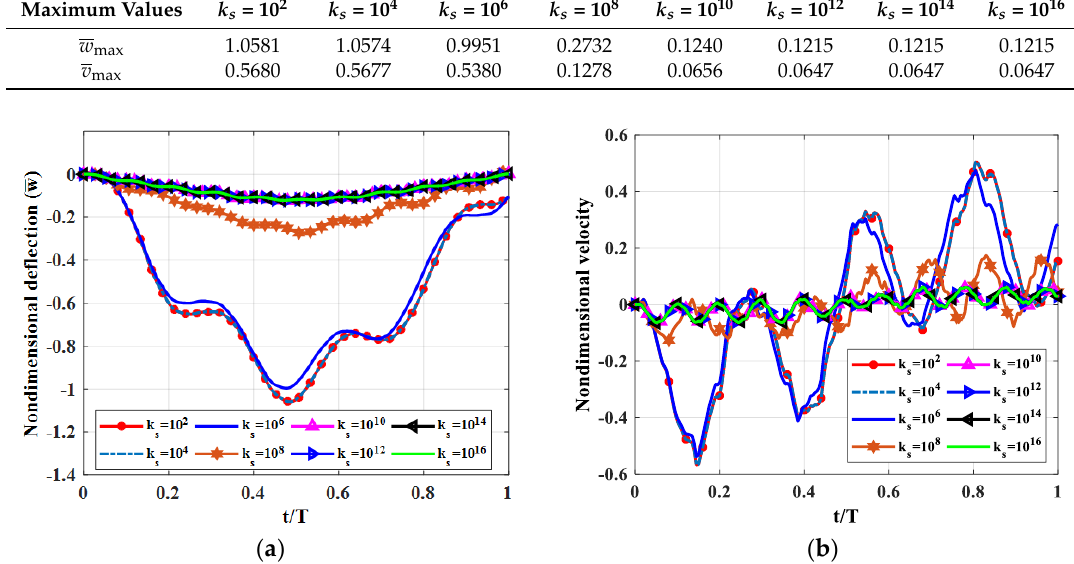
Figure 4. Dynamic deflections of the center point of the plate versus time for different shear moduli of the shear connector. ( a ): Nondimensional deflection w versus time, ( b ): Nondimensional velocity v versus time.